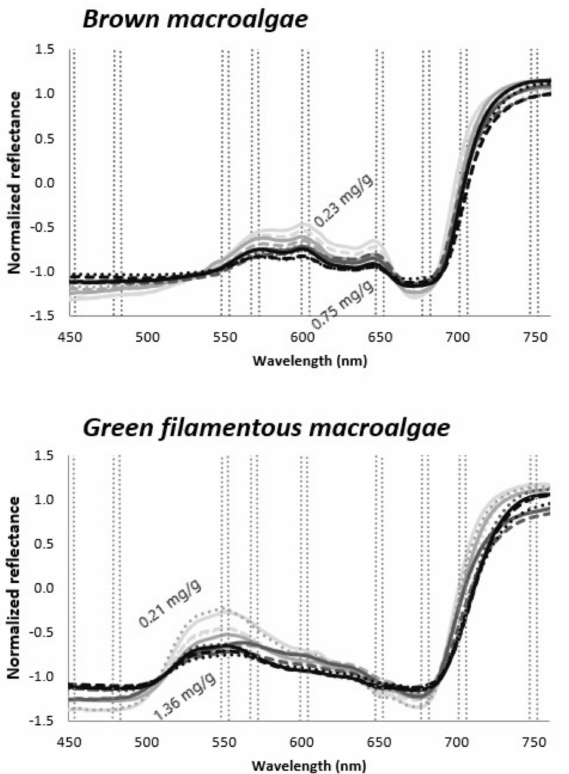
Figure 2. Examples of normalized reflectance spectra of brown macroalgae and green filamentous macroalgae representing various chlorophyll concentrations; lighter gray—lower concentrations, black—higher concentrations. Spectral regions used for index development are marked with dotted lines. Data taken from the WW